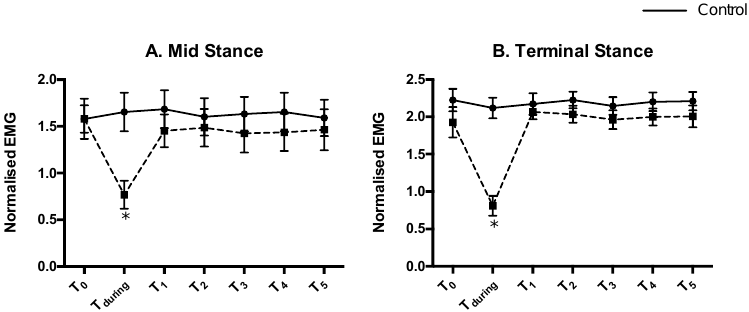
Figure 9. Group means ( ± SEM) of the medial head of gastrocnemius (GA) muscle activity during ( A ) mid-stance and ( B ) terminal stance during control and unloading conditions across different epochs. * Significant difference ( p < 0.05) relative to T 0 of the corresponding condition.